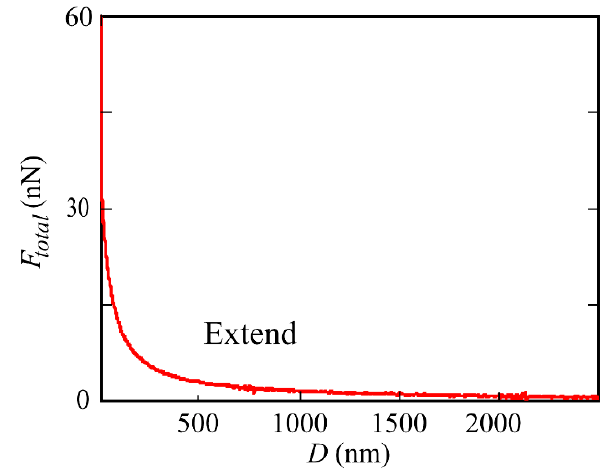
Figure 9. Force–distance curve of probe.